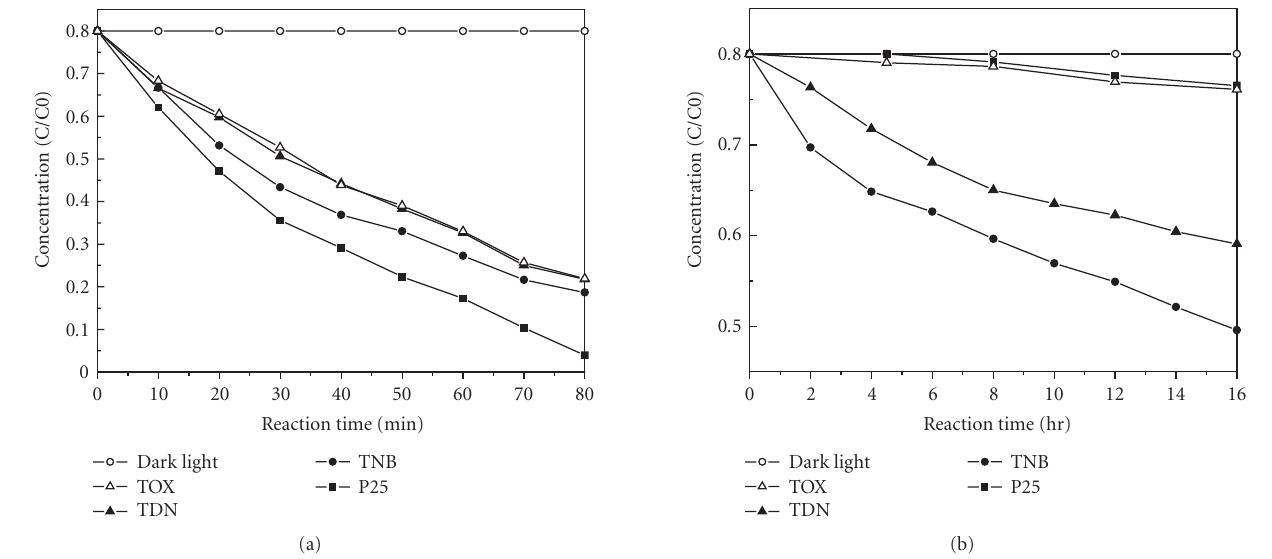
Figure 7: (a) Comparison of the UV photocatalytic activities of P25, TOX, TDN, and TNB on MB photodecomposition. Time-dependent concentration of MB in solution under UV light. (b) Comparison of the visible photocatalytic activities of P25, TOX, TDN, and TNB on MB photodecomposition. Time-dependent concentration of MB in solution under visible